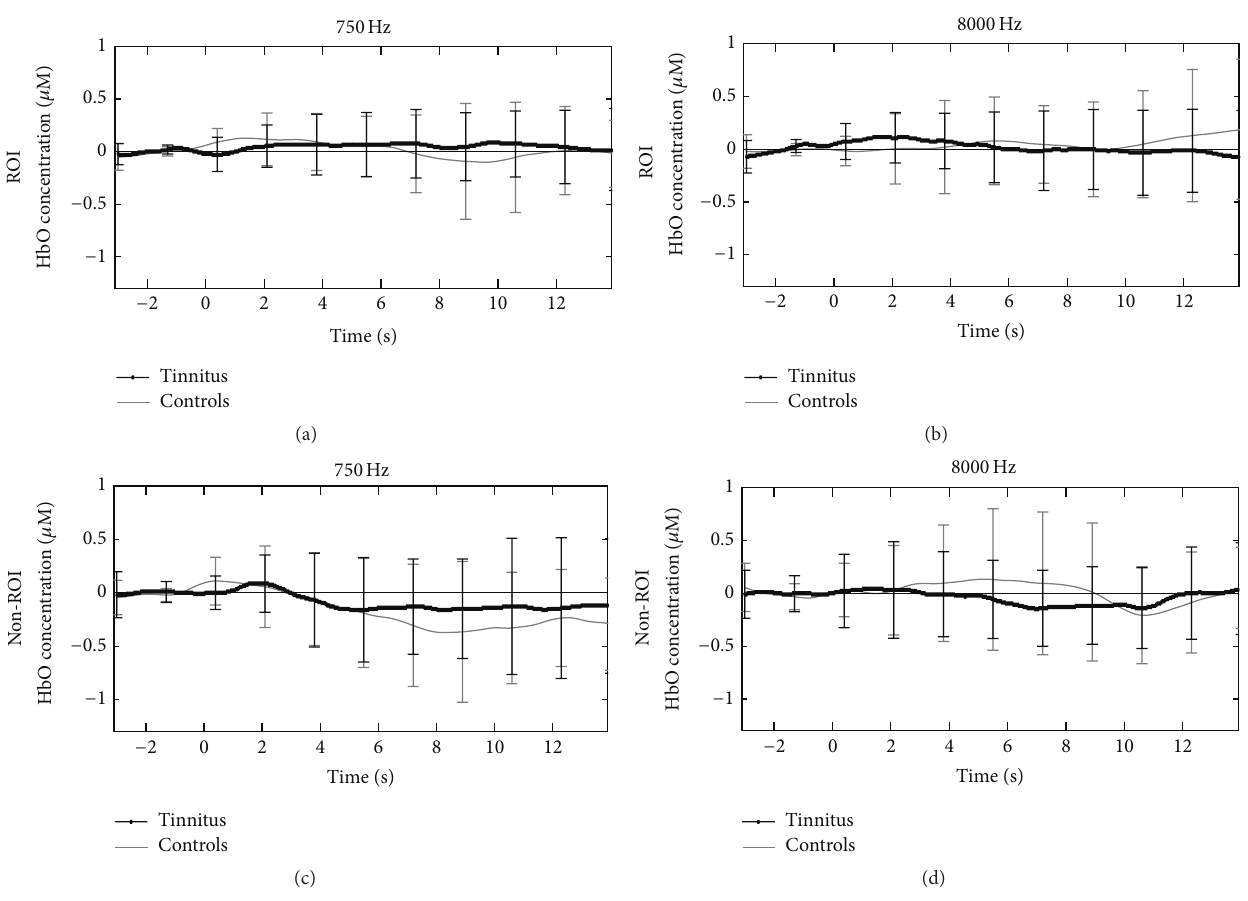
Figure 5: Mean oxy-hemoglobin (HbO) concentration traces versus time (seconds) from ROI and non-ROI under conditions of tonal auditory stimulation (750 Hz and 8000 Hz) between tinnitus (dark lines) and control (gray lines). The unit of concentration is micromolar ( 𝜇 M). Standard deviations at each time point of the traces were calculated using the equation: 𝜎 = √(Σ(𝑎 − 𝑎) 2 )/𝑁 with 𝜎 = standard deviation; 𝑎 = each value in the population; 𝑎 = the mean of the values; 𝑁 = the number of values. The panels represent brain activity during the 4–18-second time period during the respective experimental paradigm. In the figure, 0 corresponds to 4 seconds of the 18-second period. Left hand column demonstrates responses to 750 Hz in both ROI (a) and non-ROI (c). Despite variable responses no significant differences are seen between tinnitus and control. Right-hand column demonstrates responses to 8000 Hz in ROI (a) and non-ROI (b) in both groups. Again, despite variability in traces, no significant differences are seen between tinnitus and control. All traces are marked with standard errors calculated for the 4 channels (2 on the right and 2 on the left for both ROI and